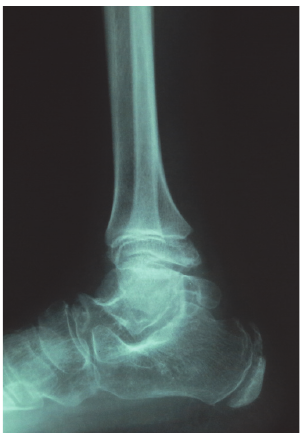
Figure 4: Lateral radiograph of right foot indicating mega os